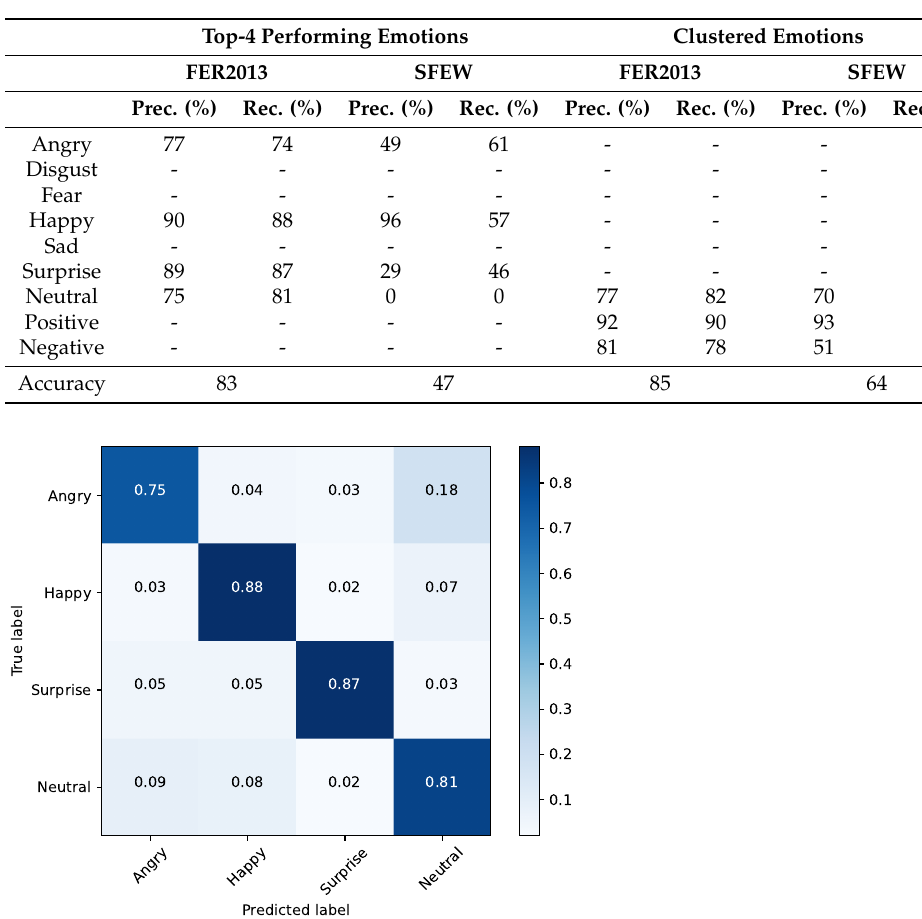
Figure 9. Training set (FER2013) and the top-4 performing emotions.